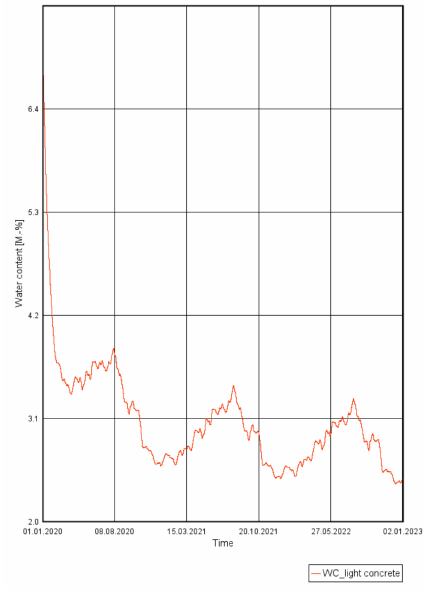
Figure 25. Changes in water content in the insulation material layer—light aerated concrete. Spatial visualisation of water content changes within the